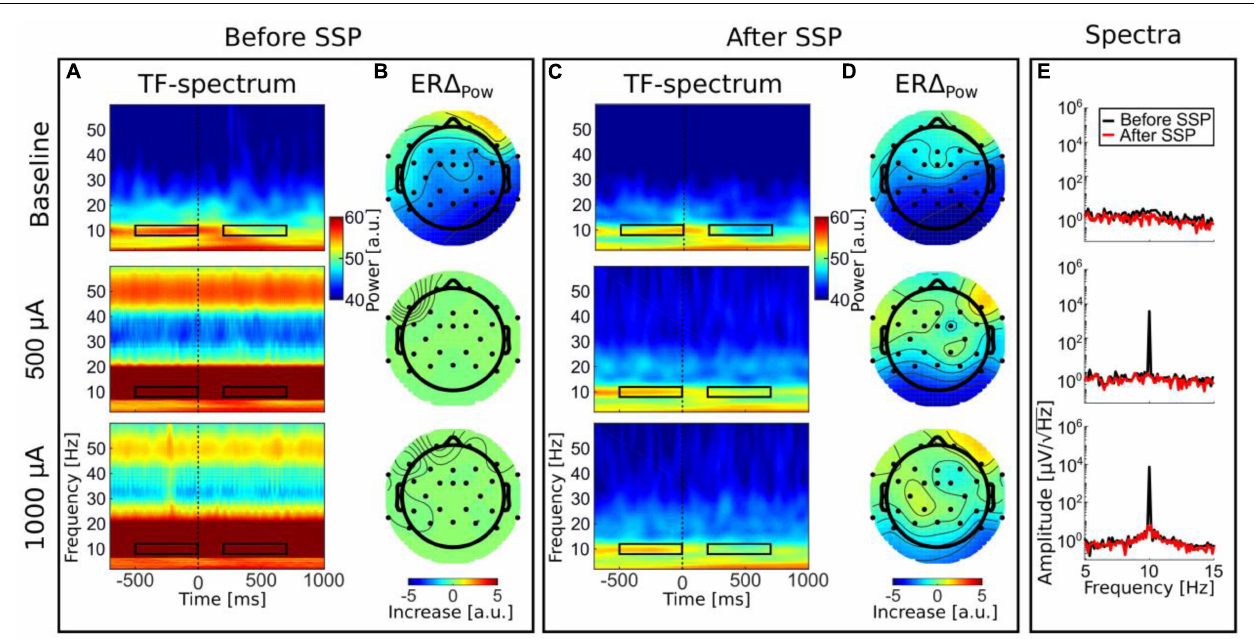
FIGURE 7 | Time–frequency results. Panels (A,B) before SSP; panels (C,D) ; after SSP. TF spectra depict decompositions of event-related EEG data from electrode Pz. Color bars are the same for all TF spectra (A,C) . Black rectangles illustrate the time–frequency sub-spectra used to calculate the ERS topographies. Panel (E) illustrates the effect of SSP on the frequency spectrum in the alpha range (5–15 Hz) on logarithmic scale. Data for panel (E) are identical to the data depicted in the other graphs but were transformed into the frequency domain by an